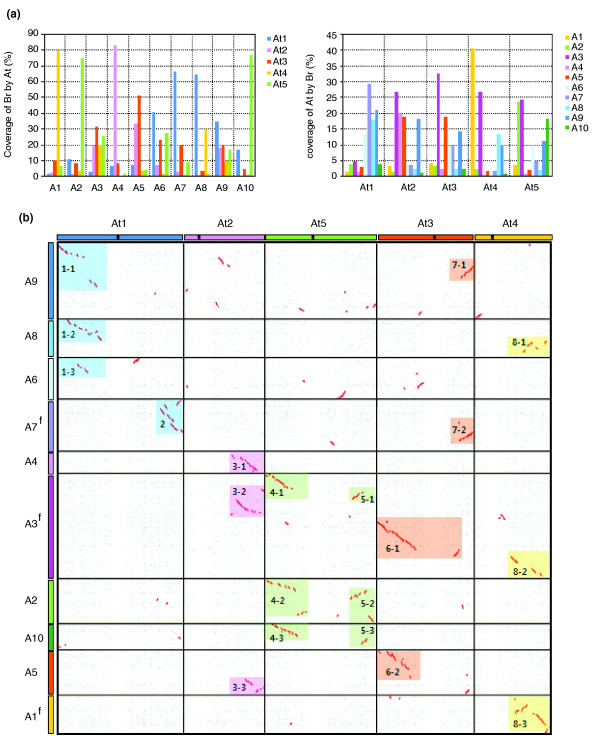
Synteny between the B. rapa and A. thaliana genomes. (a) Percent coverage of individual chromosomes showing synteny between B. rapa and A. thaliana. Coverage was calculated as the gene number of an individual chromosome per sum of genes with BLASTP hits. Note that the overall coverage of an individual chromosome for the counterpart genome can exceed 100% because multiple best BLAST hits over the same region are counted. (b) Chromosome correspondence between B. rapa and A. thaliana represented by a dot-plot. Each dot represents a reciprocal best BLASTP match between gene pairs at an E-value cutoff of <E-20. Red dots show regions of synteny with more than 50% gene conservation as identified by DiagHunter. Some Br chromosome orientations have been flipped (A1f, A3f, A7f) to visually correspond to At orientations. Both Br and At have been scaled to occupy the same lengths. Color bars on the upper and left margins of the dot plot indicate individual chromosomes of At and Br, respectively. Black dots on the At chromosomes are centromeres. The color-shaded boxes in the dot plots represent long-range synteny blocks along chromosome pairs. Boxes with the same color are putative triplicated remnants. See Additional data file 3 and the URL cited in Materials and methods for all dot plots and related results, including detailed close-ups of regions of synteny.